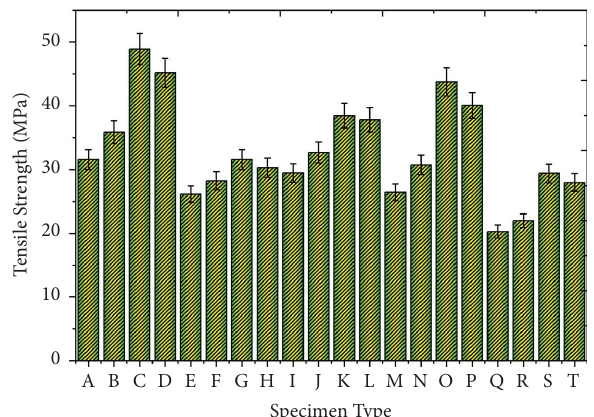
Figure 4: Tensile strength of biosynthesised Al epoxy hybrid composites.